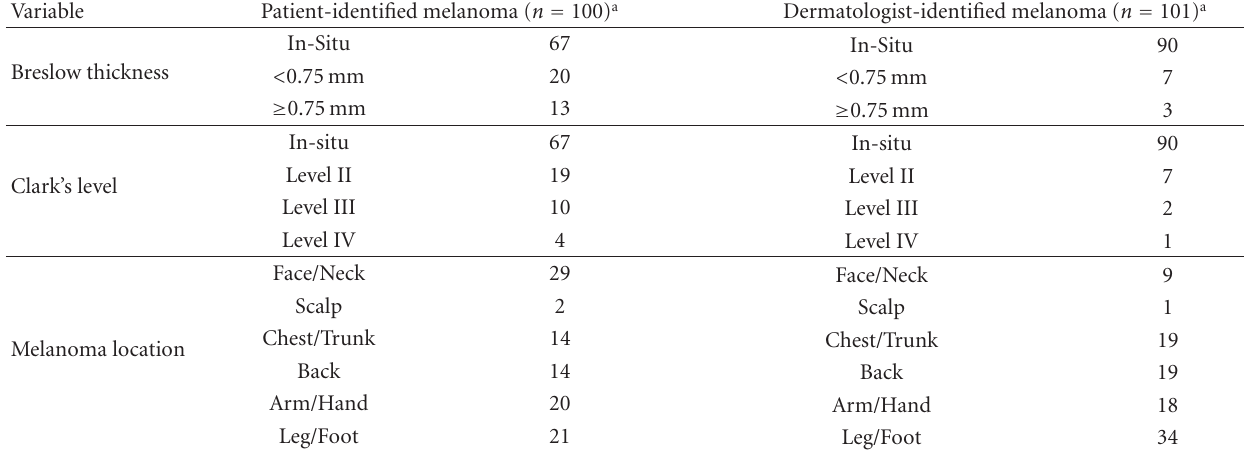
Table 2: Melanoma